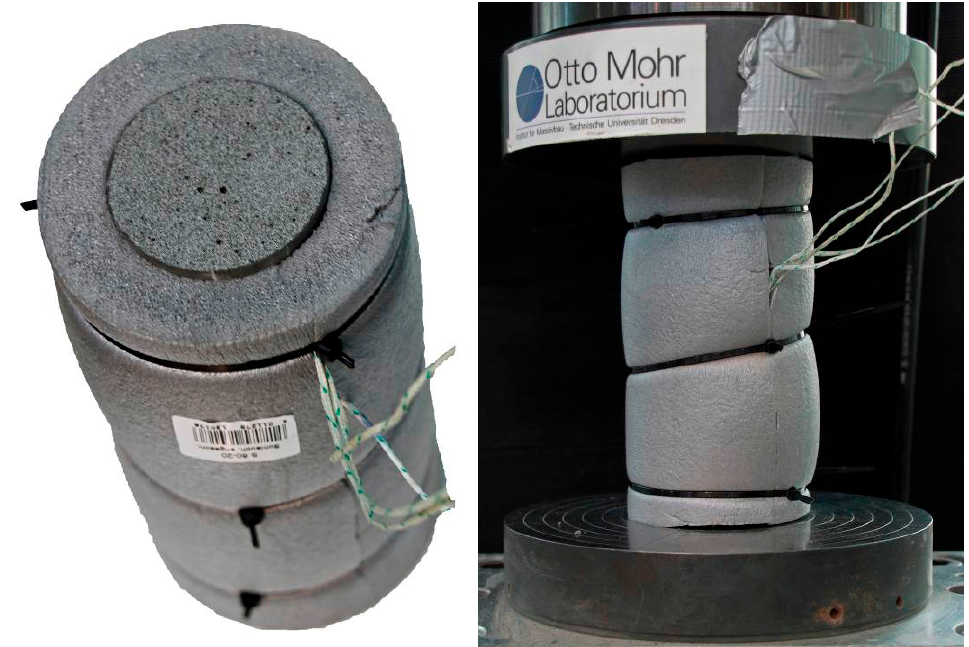
Figure 4. Sample with thermocouples and thermal insulation.